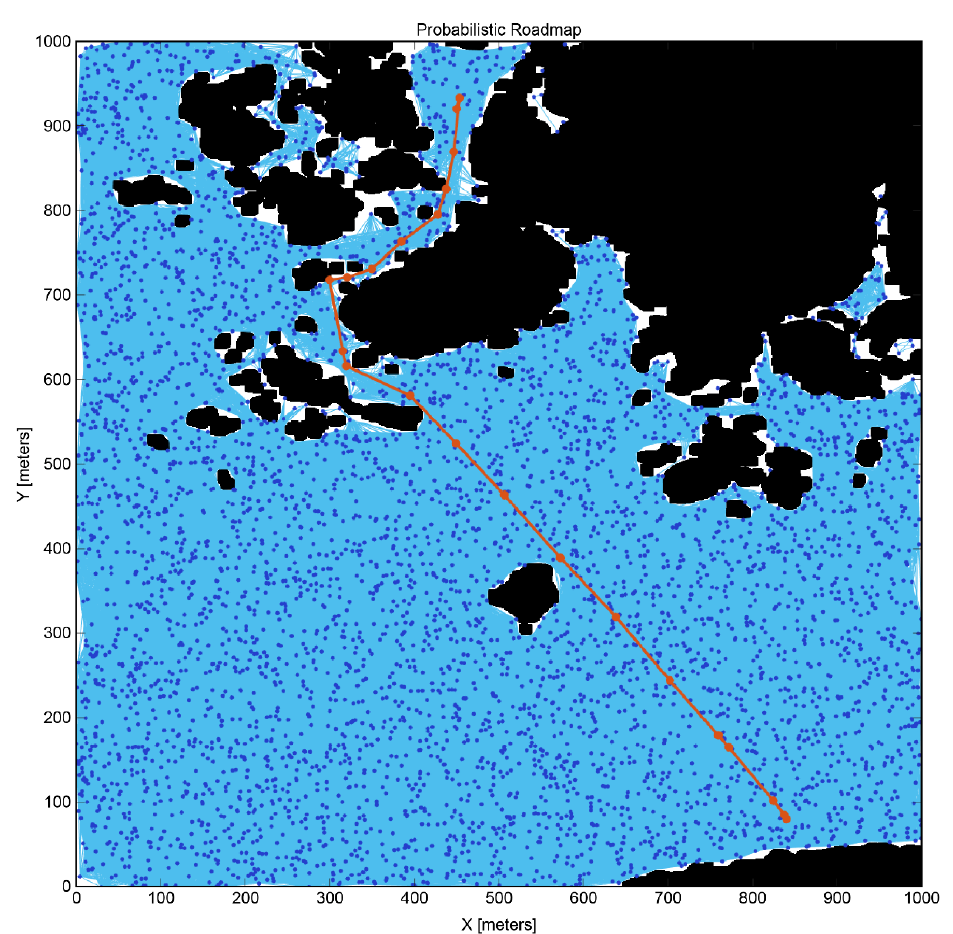
Figure 18. Initial route generation results using the PRM algorithm. A multi ‐ ellipse space was created based on the initial route generated using the PRM algorithm, as shown in Figure 19.